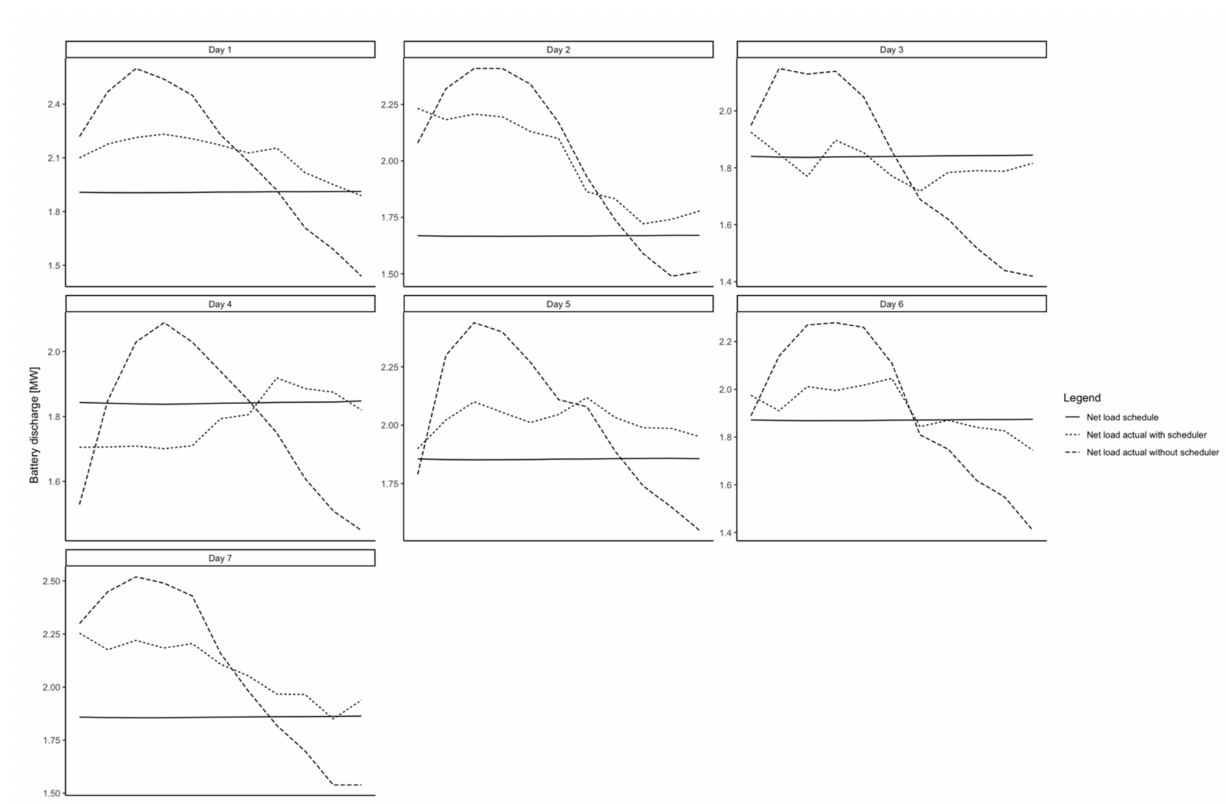
Figure 3. Net load realized using schedules generated from both schedulers.